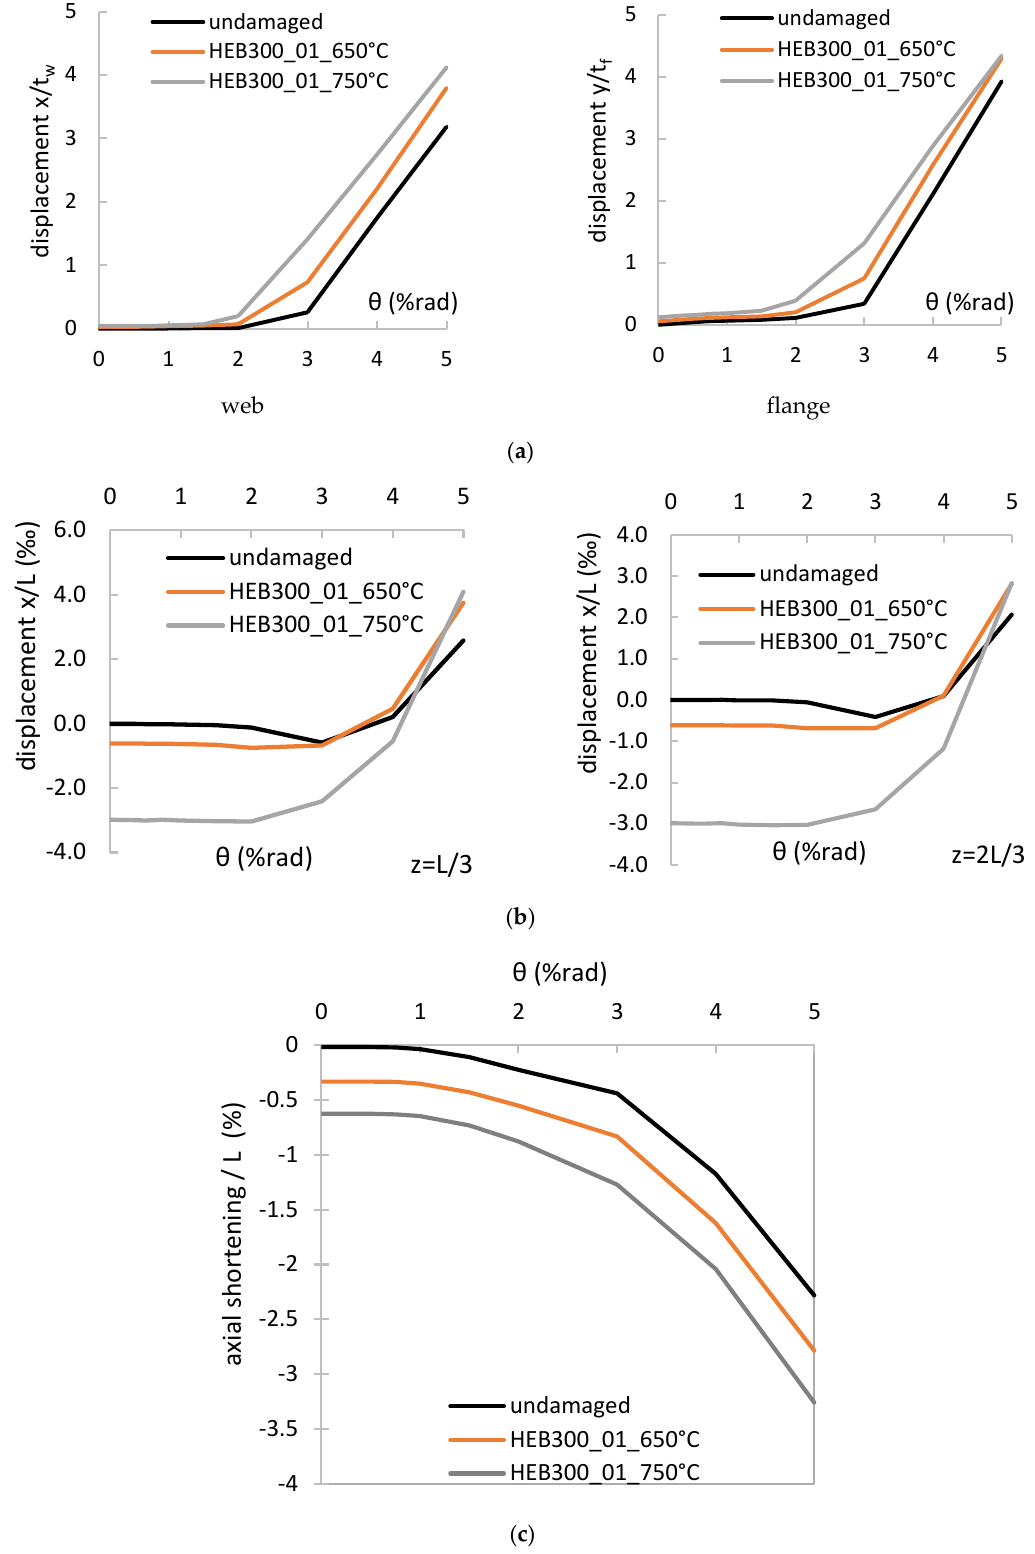
Figure 12. First cycle envelope curves of: ( a ) the normalized out ‐ of ‐ plane displacements at the center of local buckles, ( b ) the global out ‐ of ‐ plane displacements for the HEB300_01 columns, and ( c ) the normalized axial shortening of HEB300_01 columns.